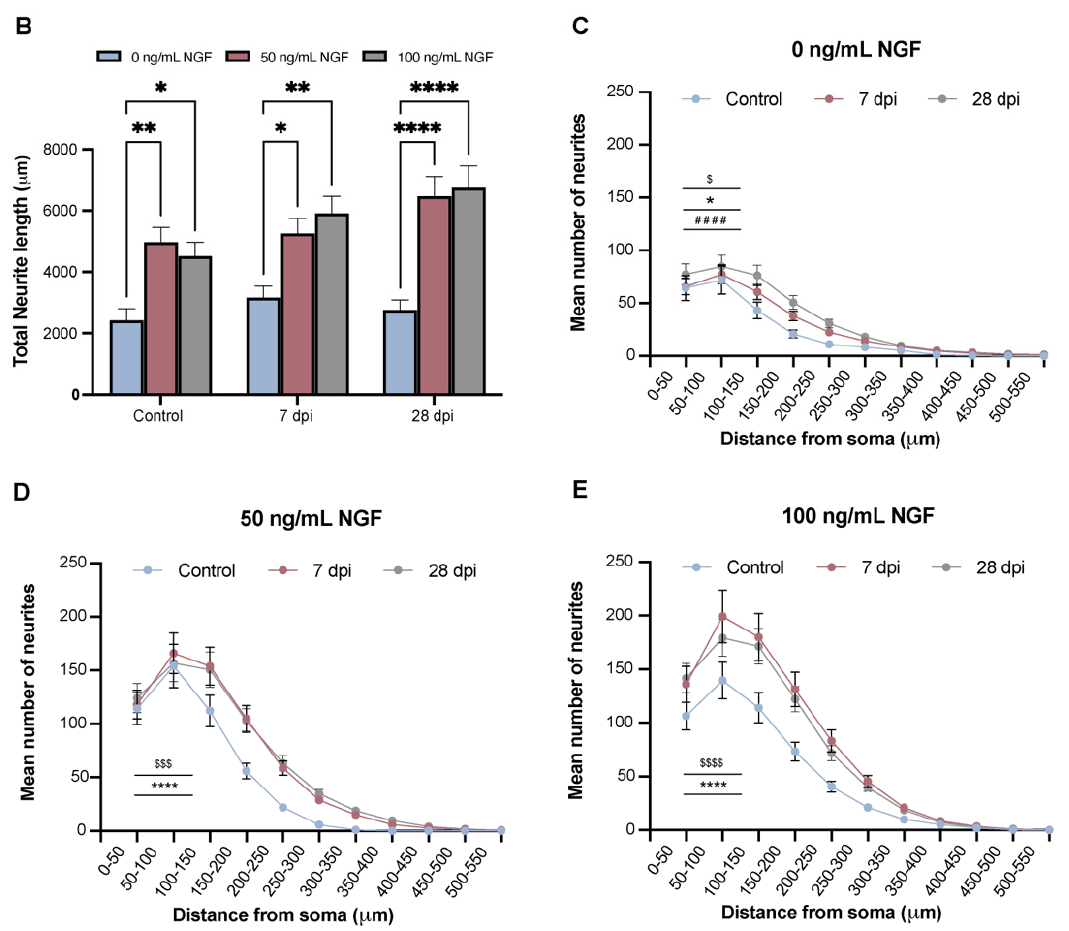
Figure 6. In vitro experiments using lumbosacral (L5-S1) DRG neurons from spinal intact (control) and SCT animals (7 and 28 dpi (days post-injury)) cultured for 22 h in distinct concentrations of NGF (0, 50 and 100 ng/mL). DRG neurons from control and SCT animals were immunostained against β III- tubulin, and analysis showed that neurons emitted long and ramified neurites, which were more prominent in cells from SCT animals ( A ). Axonal growth was exacerbated by the presence of NGF in the culture medium. Scale bar: 100 µm. Total neurite length ( B ) of cultured DRG cells significantly increased in all experimental groups treated with either 50 ng/mL or 100 ng/mL of NGF, compared to animals treated with 0 ng/mL of NGF. Graphs represent mean ± SEM and p < 0.05 was considered statistically significant. * p ≤ 0.05; ** p ≤ 0.01; **** p ≤ 0.0001; two-way ANOVA followed by Newman–Keuls multiple comparison test. Correlation between mean number of branches and distance from the soma ( C – E ) indicated that branching was significantly upregulated by NGF dosage in SCT animals, compared to controls. Graphs represent mean ± SEM and p < 0.05 was considered statistically significant. ( C ) $ p ≤ 0.05 7 dpi vs. control animals; * p ≤ 0.05 28 dpi vs. control animals; #### p ≤ 0.0001 7 dpi vs. 28 dpi animals. ( D ) $$$ p ≤ 0.001 7 dpi vs. control animals; **** p ≤ 0.0001 28 dpi vs. control animals. ( E ) $$$$ p ≤ 0.0001 7 dpi vs. control animals; **** p ≤ 0.0001 28 dpi vs. control animals; two-way ANOVA followed by Tukey’s multiple comparison test. To investigate whether NGF would potentiate axonal growth by interfering with the expression of CSPGs, MAIs and repulsive guidance molecules receptors, RNA was ex- tracted from cultured DRG cells from control and SCT animals (7 and 28 days post-injury)